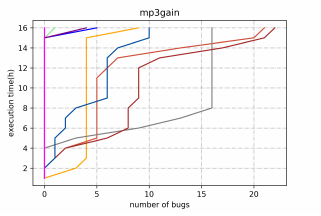
Figure 4. Number of bugs and execution time in exploration stage.